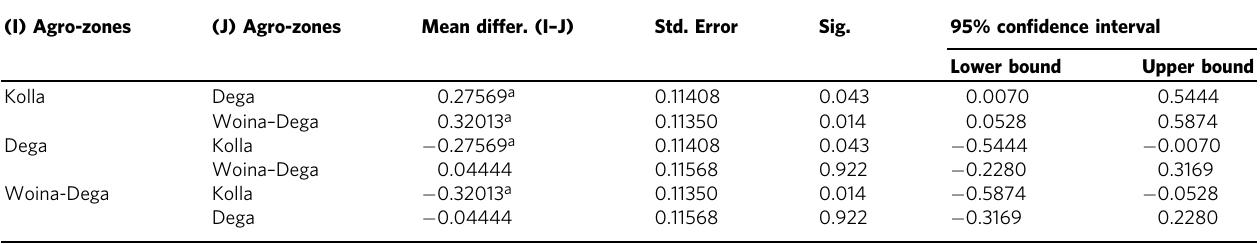
Table 5 Multiple comparisons between agro-zones by farmland size.